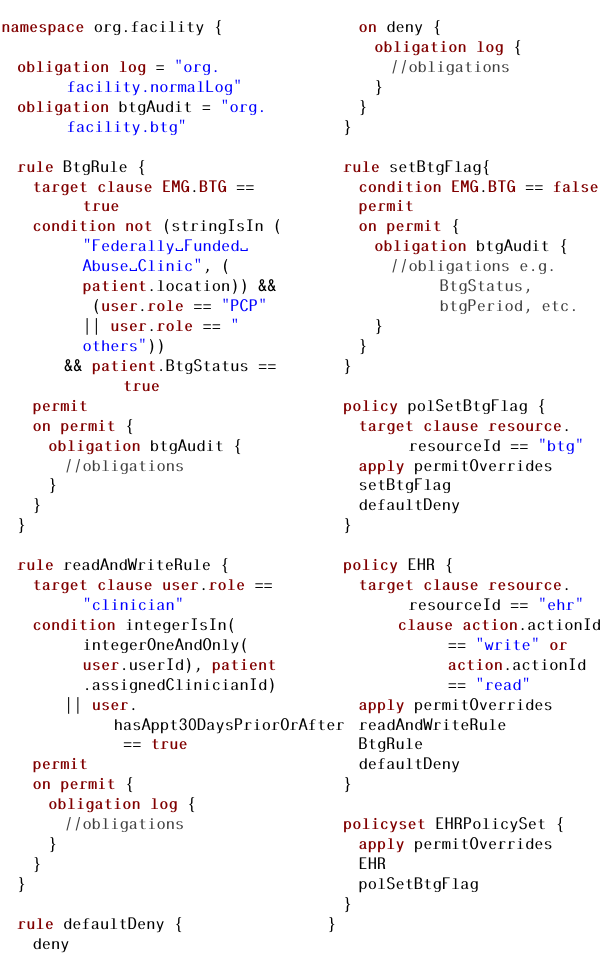
Figure 7. Sample BTG policy from a major medical group,